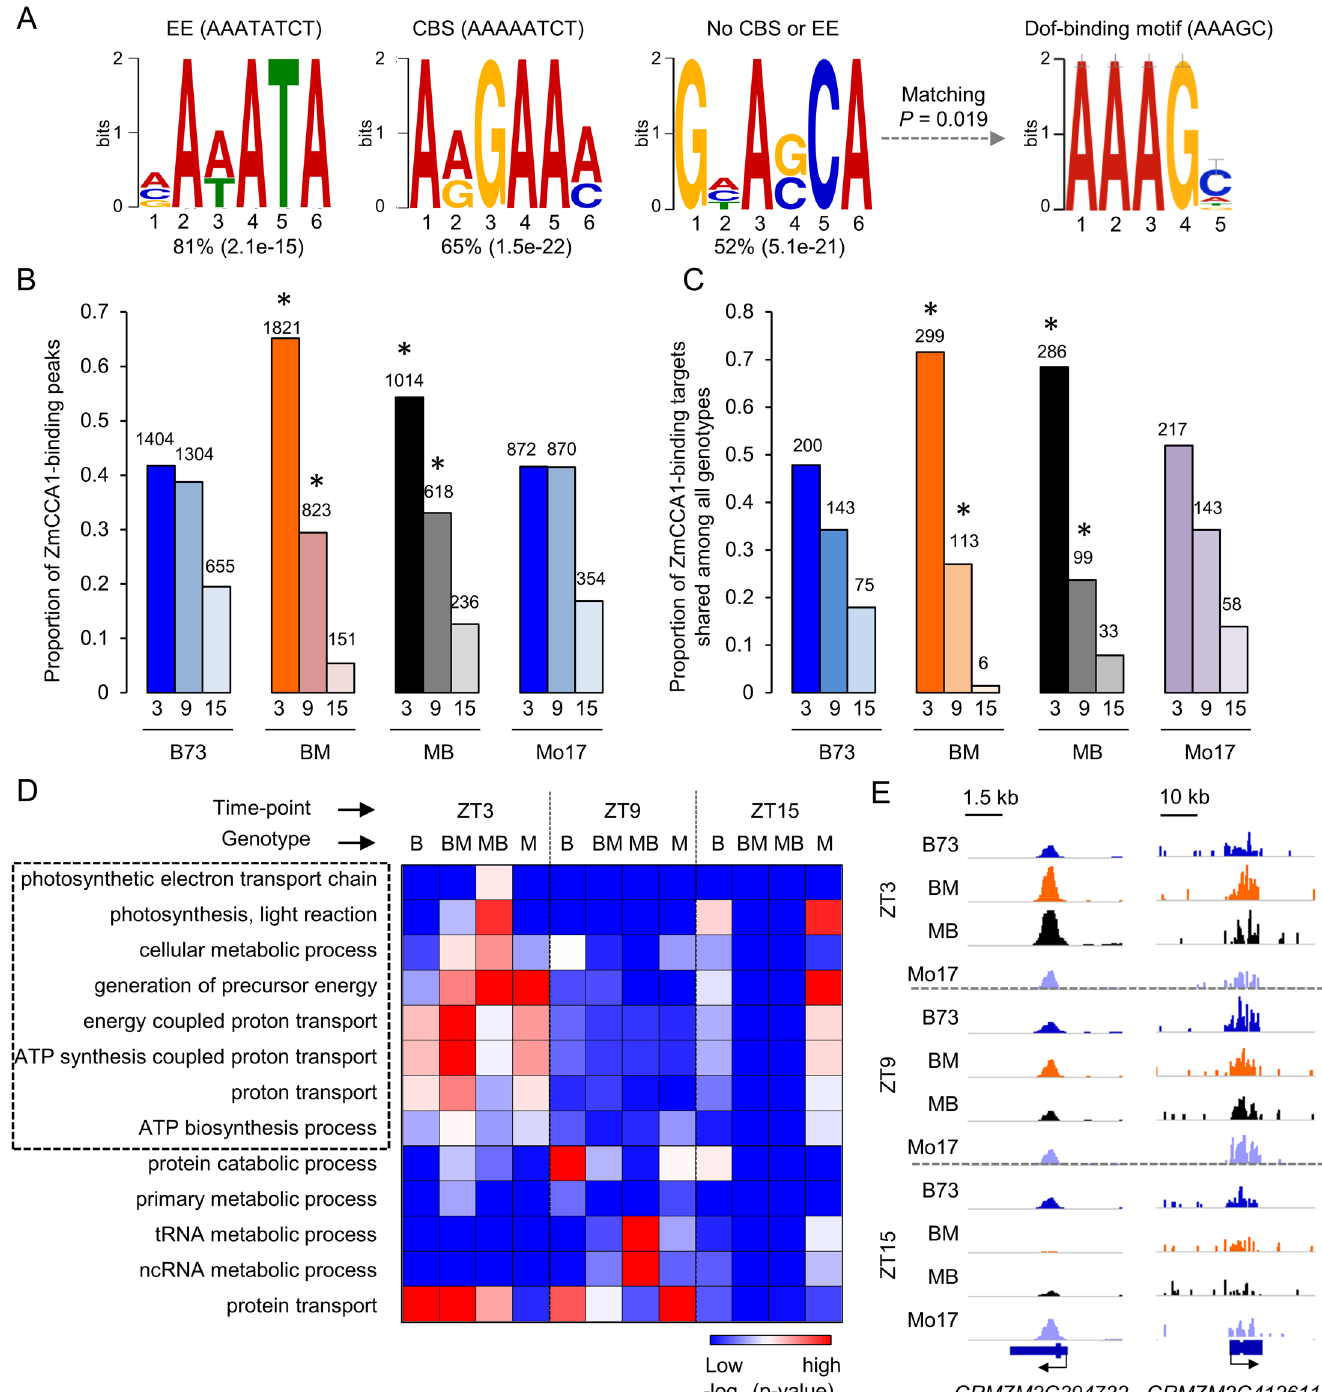
Fig 5. ChIP-seq analysis of ZmCCA1s in the maize inbreds and F1 hybrids. (A) De novo motif analysis of ZmCCA1-binding sites using MEME suites showed enrichment of EE, CBS, and no CBS or EE motifs. In the latter, Dof-binding motif was significantly matched in TOMTOM analysis. Percentage (p- value) is shown below each motif. (B and C) Proportion of ZmCCA1-binding peaks (B) and binding targets (C) shared in all genotypes at each time-point. Asterisks indicate statistical significance of ZT3 or ZT9 frequencies between the F1 hybrids and their parents were calculated by Fisher ’ s exact test. The number of peaks or genes is shown above each bar. (D) Gene Ontology (GO) classification of ZmCCA1-binding targets in each genotype at each time point by GO analysis (false-discovery rate adjusted p-value < 0.05, Hypergeometric test). GO terms associated with carbon fixation are marked by a dashed box. (E) Examples of altered temporal bindings of ZmCCA1s in F1 hybrids compared to the inbred lines. The Y-axis indicates input-subtracted read density on a same-scale for all genotypes and time-points. Arrows indicate gene orientation.